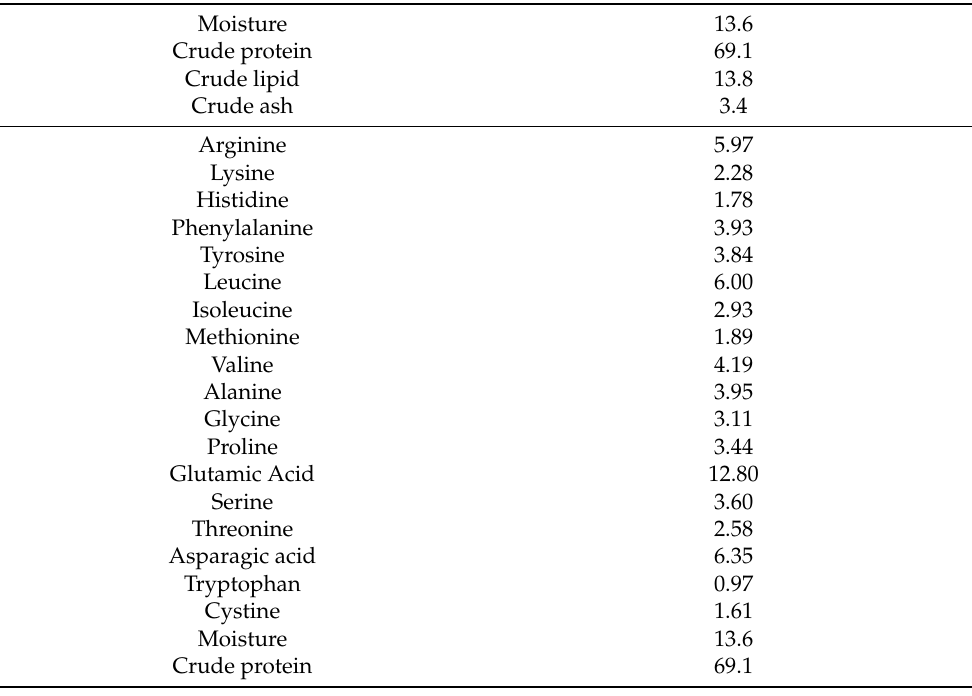
Table 1. The proximate and amino acid composition of RPC.